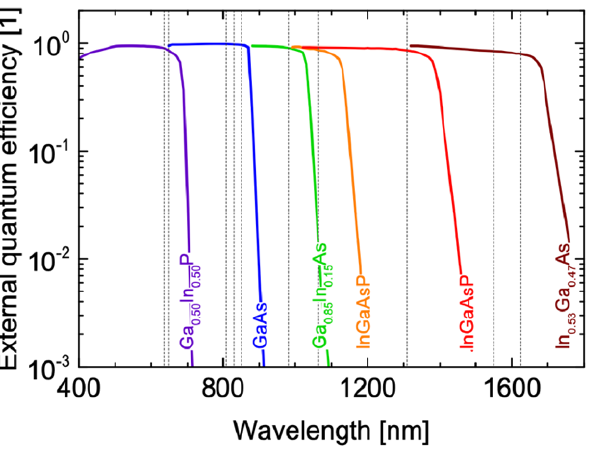
Figure 2. Examples of external quantum efficiency of III-V compound semiconductor materials [16].